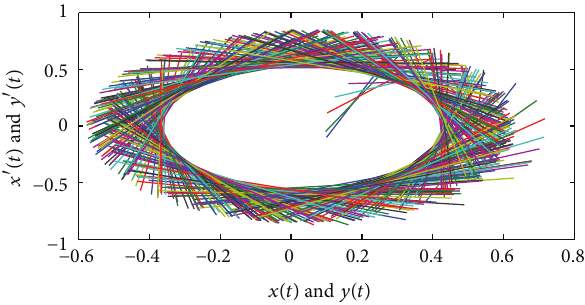
Figure7:Phaseresponseofstatevariables 𝑥(𝑡) , 𝑦(𝑡) , 𝑥 󸀠 (𝑡) ,and 𝑦 󸀠 (𝑡)